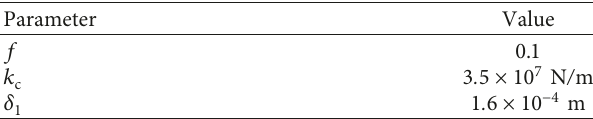
Table 3: Values of the parameters for rub-impact.